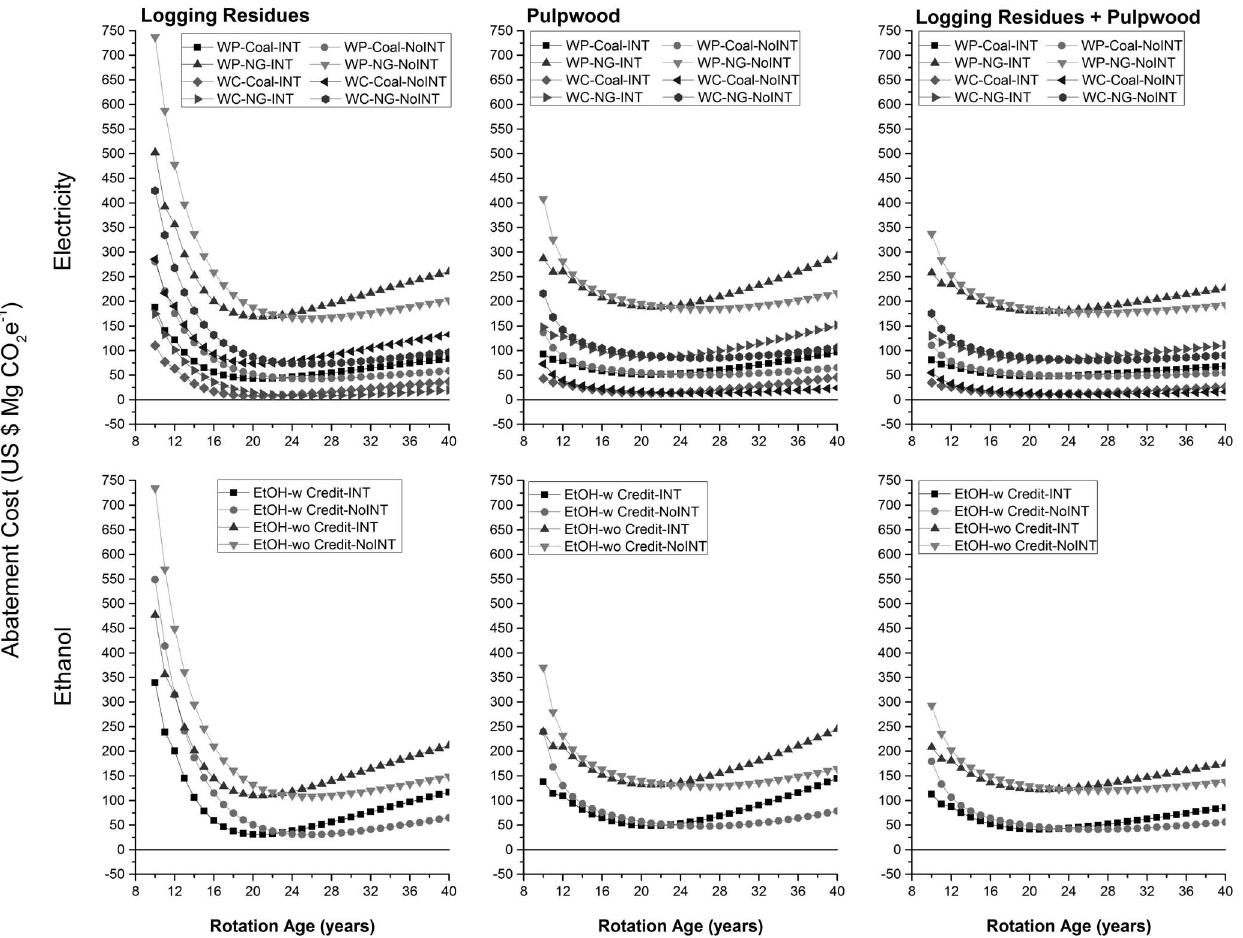
Figure 9. Abatement cost of GHG emissions with respect to corresponding fossil fuel-based energy products. LR: logging residues; PW: pulpwood; WP: wood pellets; WC: wood chips; w: with income from cogenerated electricity; wo: without income from cogenerated electricity.